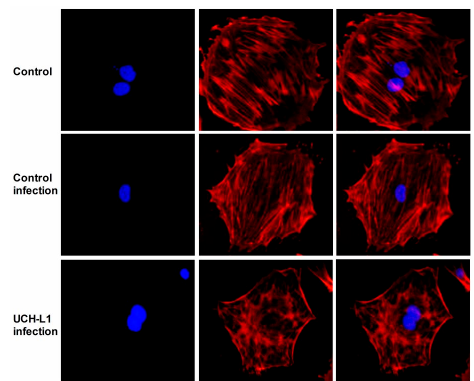
Figure 5. Effect of UCH-L1 overexpression on structure injury in podocytes. Immunofluorescence staining of F-actin was performed in podocytes of control group, control infection group and UCH-L1 infection group. F-actin was showed in red, cell nucleus showed with DAPI in blue ( n = 5). Original magnification, 200 × .